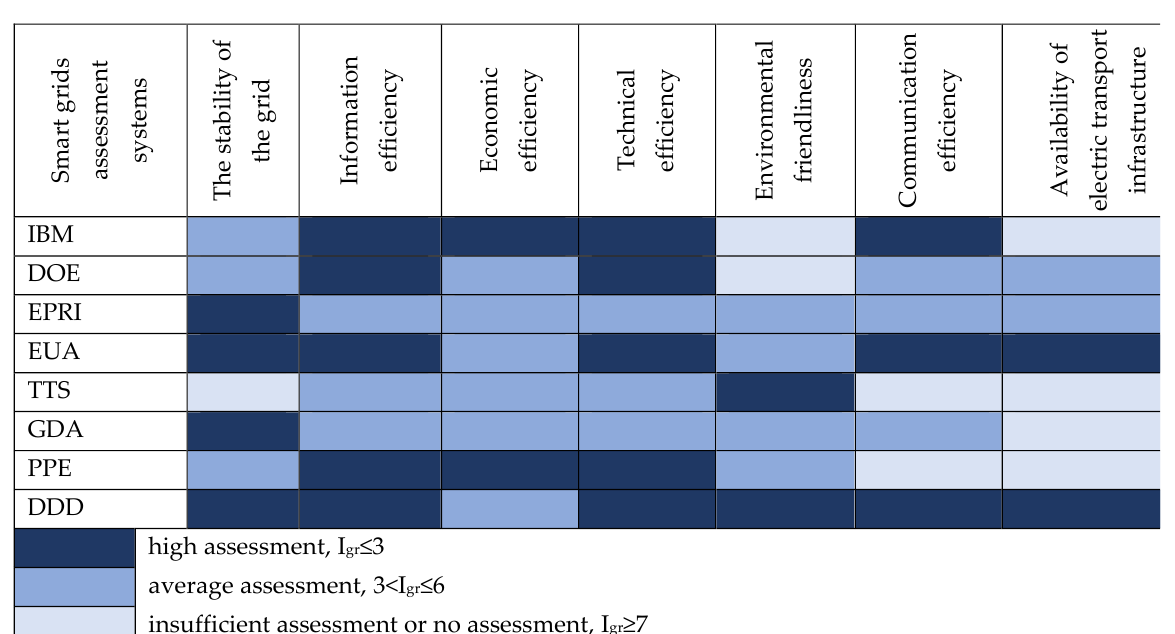
Figure 6. The generalized comparative matrix of smart grid assessment